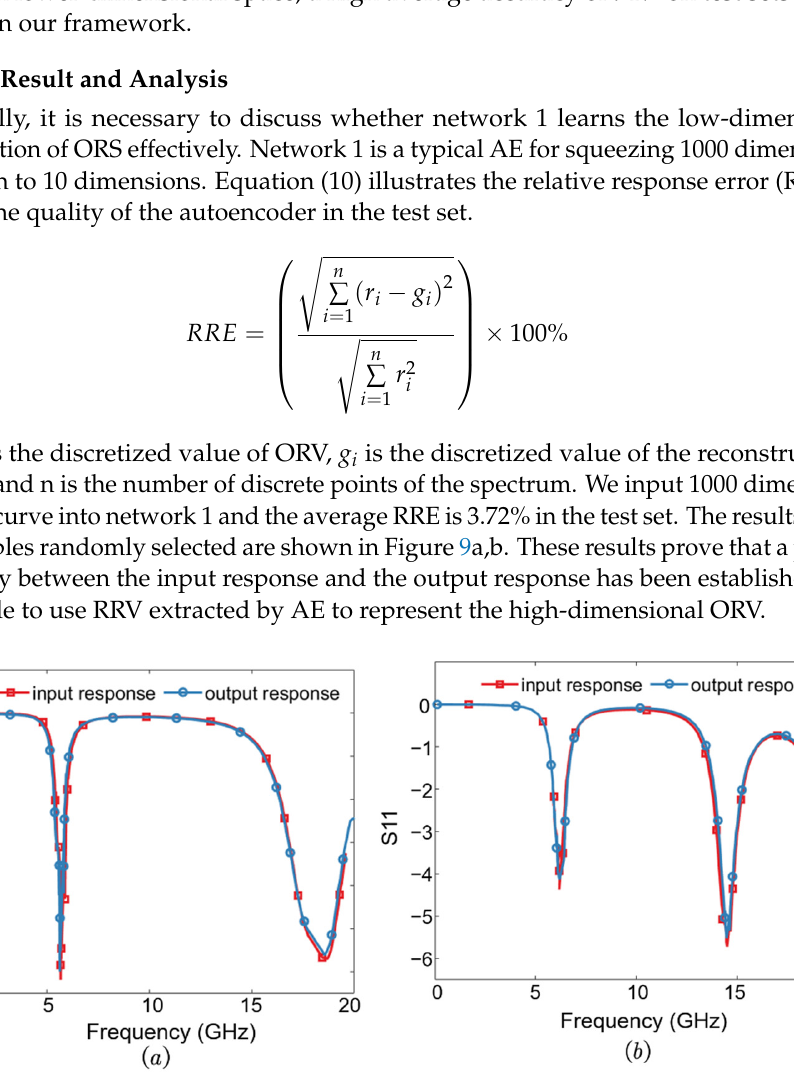
Figure 8. Flowchart of the VAE-PSO algorithm.